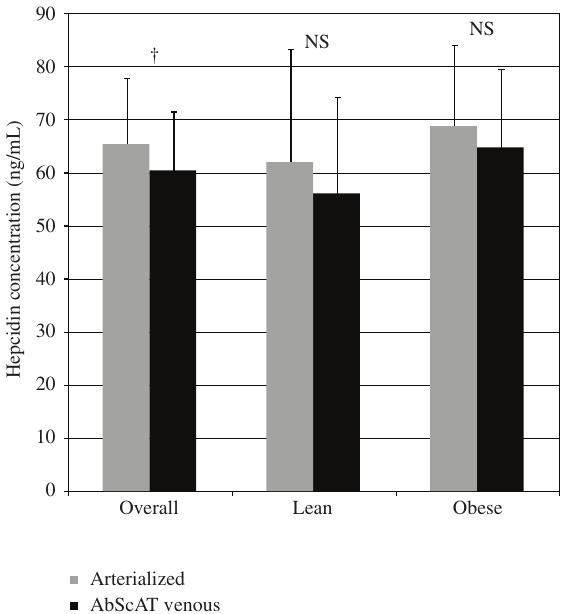
FIGURE 1: Postabsorptive arterialized dorsal hand vein and abdominal subcutaneous adipose tissue (AbScAT) venous plasma concentrations of hepcidin in obese ( n = 9 ) and lean ( n = 9 ) adults. Comparison between arterialized and venous sites was assessed using paired t -tests. † Significantly different at 0.05 level. NS: not significantly different at 0.05